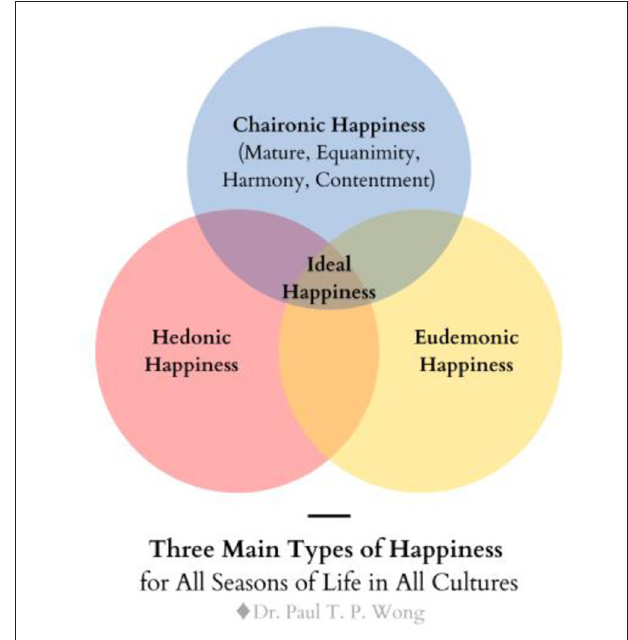
FIGURE 1 | Different types of happiness.